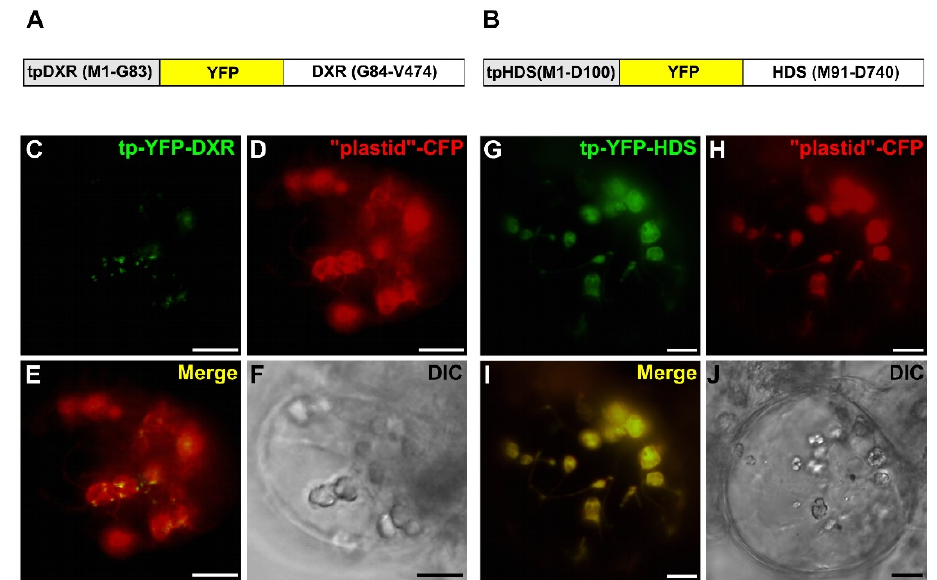
Figure 8. Subcellular localization of DXR and HDS studied using internal YFP protein fusions. C. roseus cells were transiently transformed with plasmids expressing internal YFP fused to split DXR ( A ) and HDS ( B ). The fluorescence emitted by YFP-fused proteins ( C , G ) was compared to the fluorescence emitted by the plastid-CFP marker ( D , H ). Colocalization of the two signals appeared in yellow by merging the two individual (green/red) color images ( E , I ). Cell morphology is observed with differential interference contrast (DIC, F , J ). Bar: 10 µm.